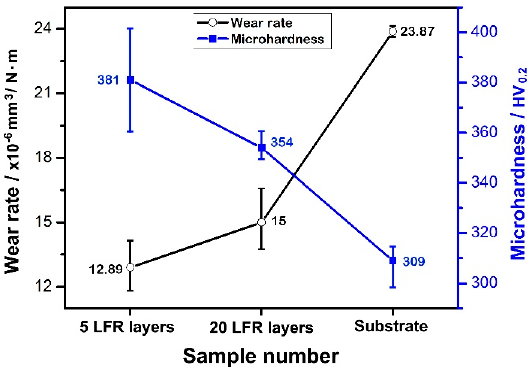
Figure 10. Wear rate and microhardness of three kinds of wear testing samples.